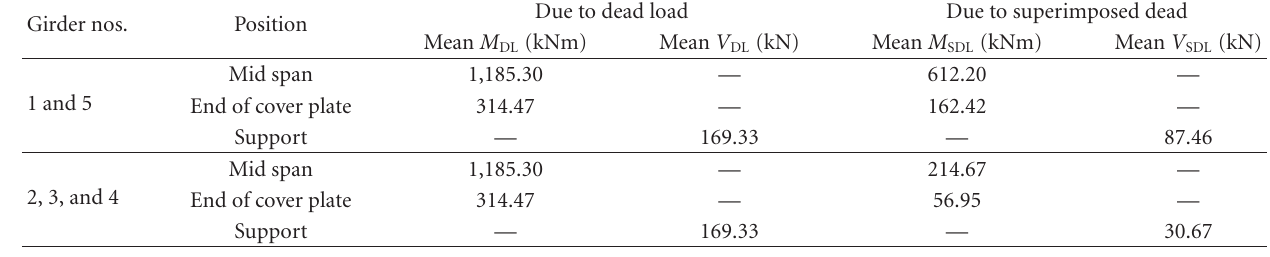
Table 3: Moments and shears due to dead and superimposed dead loads ( M DL , M SDL , V DL , and V SDL ). Girder nos.